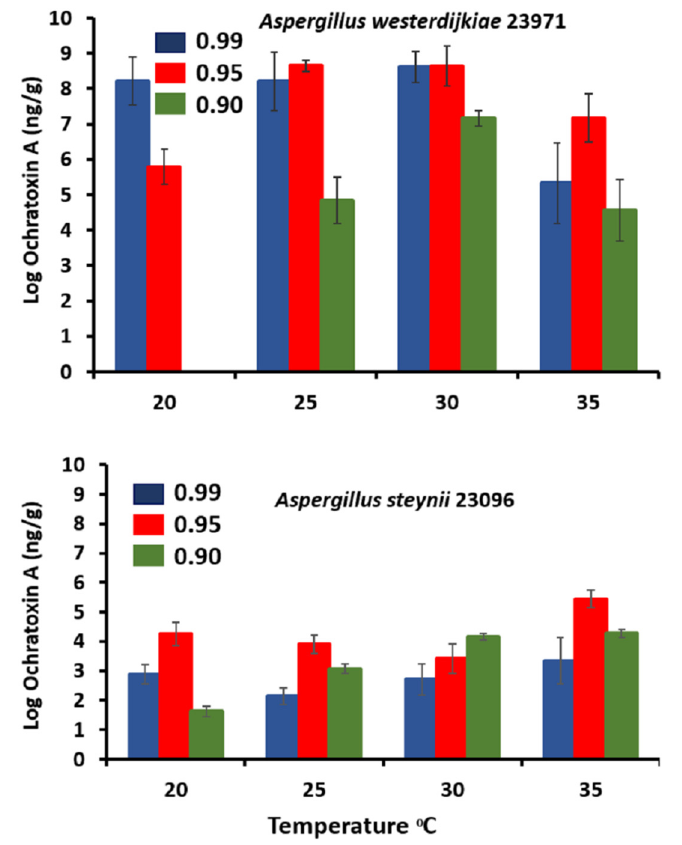
Figure 3. Ochratoxin A of A. westerdijkiae IBT 23971 and A. steynii IBT 23096 in relation to temperature and water activity (a w ) in the YES medium. Vertical bars show standard errors for all strains.